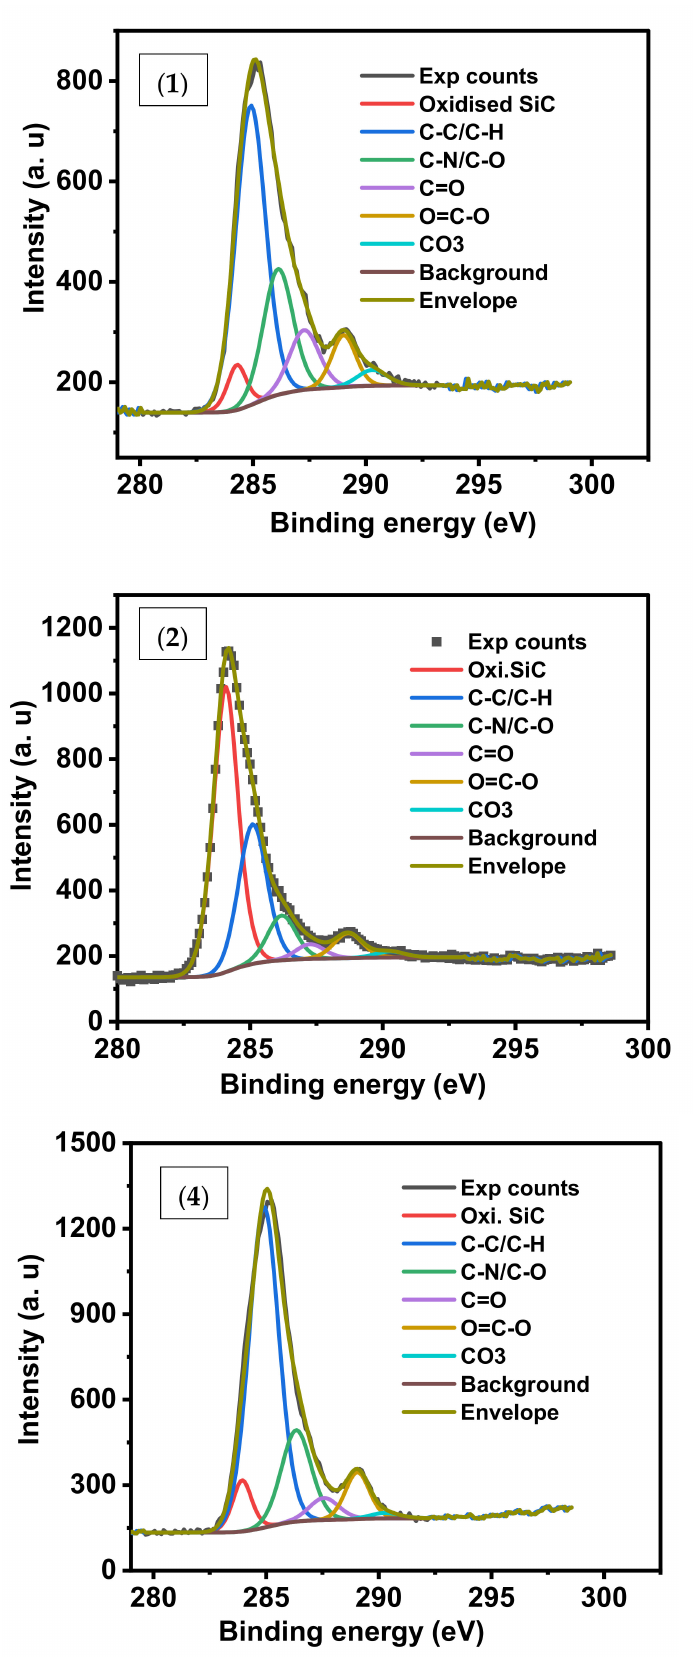
Figure 6. XPS C1s deconvoluted spectrum for samples (1), (2) and